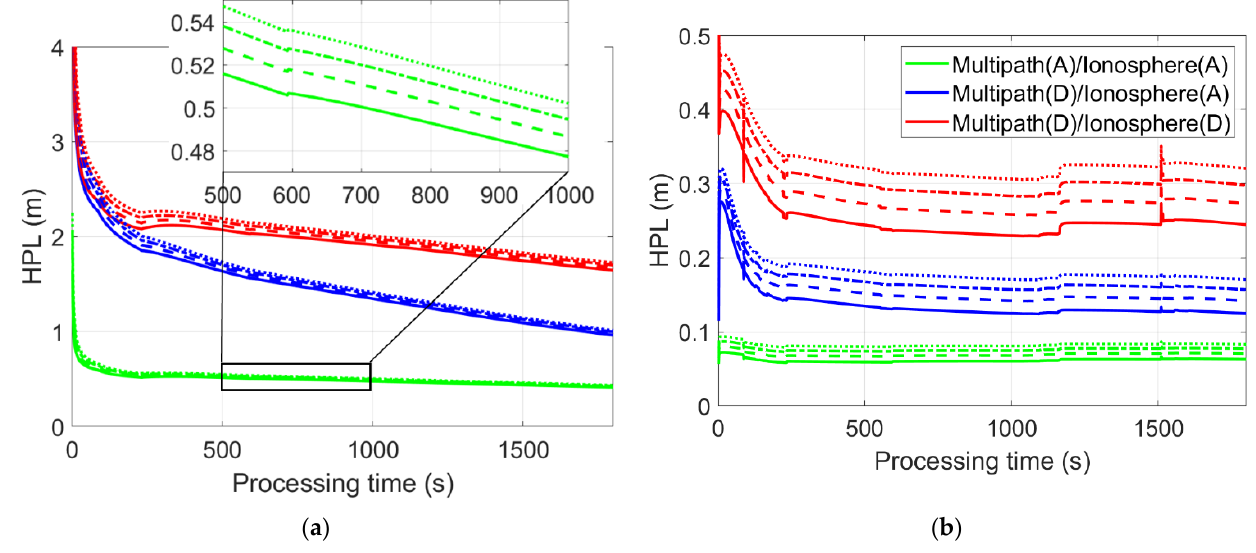
( b ) Figure 9. HPLs under different multipath environments and ionosphere conditions ( a ) without and